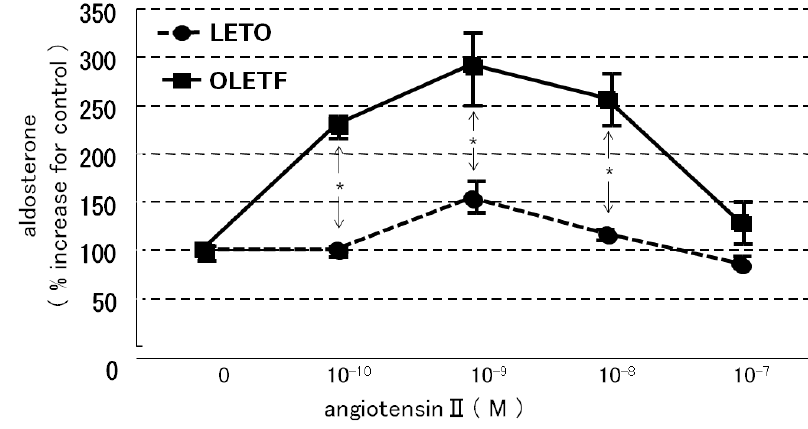
Figure 5. Effect of angiotensin II in the presence of 20 mg cholesterol/dL of HDL on aldosterone production by rat AoSMC. Data are expressed as percentage increases compared with the control. Data are presented as mean ± S.E.M. values of three different